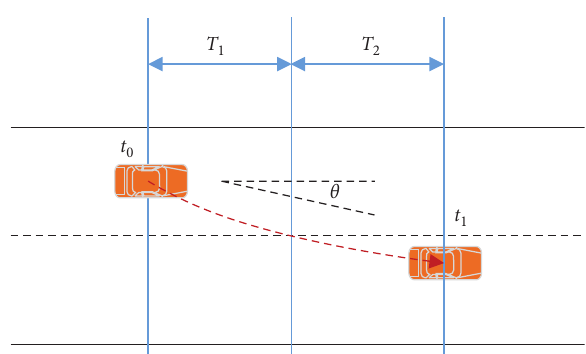
Figure 2: Schematic diagram of a lane-change process.